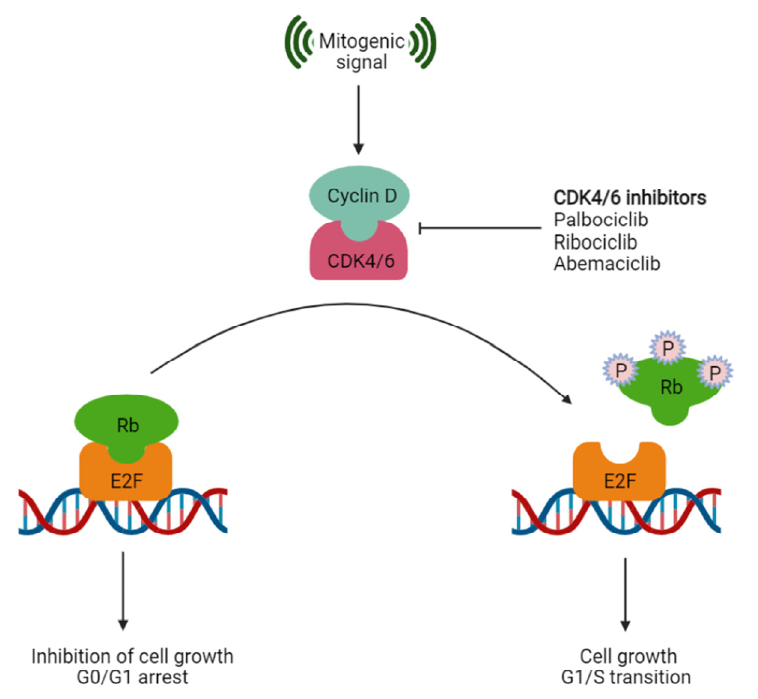
Figure 1. A schematic diagram of CDK4/6 function depicting the role of phosphorylation and inac- tivation of retinoblastoma protein (Rb). The mitogenic signal stimulates the formation of the Cyclin D-CDK4/6 complex, which subsequently phosphorylates Rb, leading to the release of E2F transcrip- tion factors, thus triggering the expression of the gene responsible for the G1-S phase transition. CDK4/6 inhibitors prevent Rb phosphorylation, thereby arresting the cell cycle.